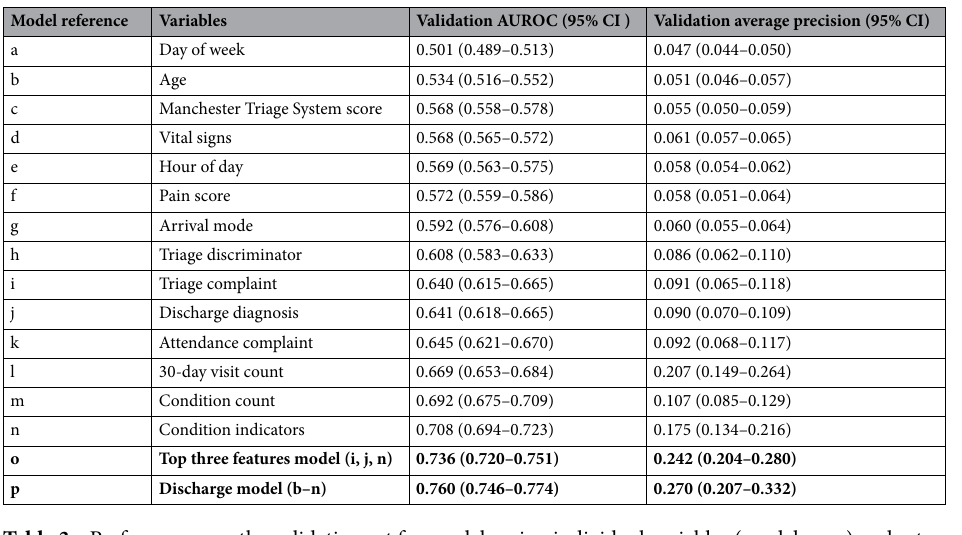
Table 3. Performance on the validation set for models using individual variables (models a–n) and sets of variables (models o and p). Bold text indicates models trained using multiple variable sets. Metrics are evaluated on the training set using grouped 5-fold CV at the patient level and we report the mean of the metric across the five validation folds. All models hyperparameters were tuned as described in the methods section to optimize the CV